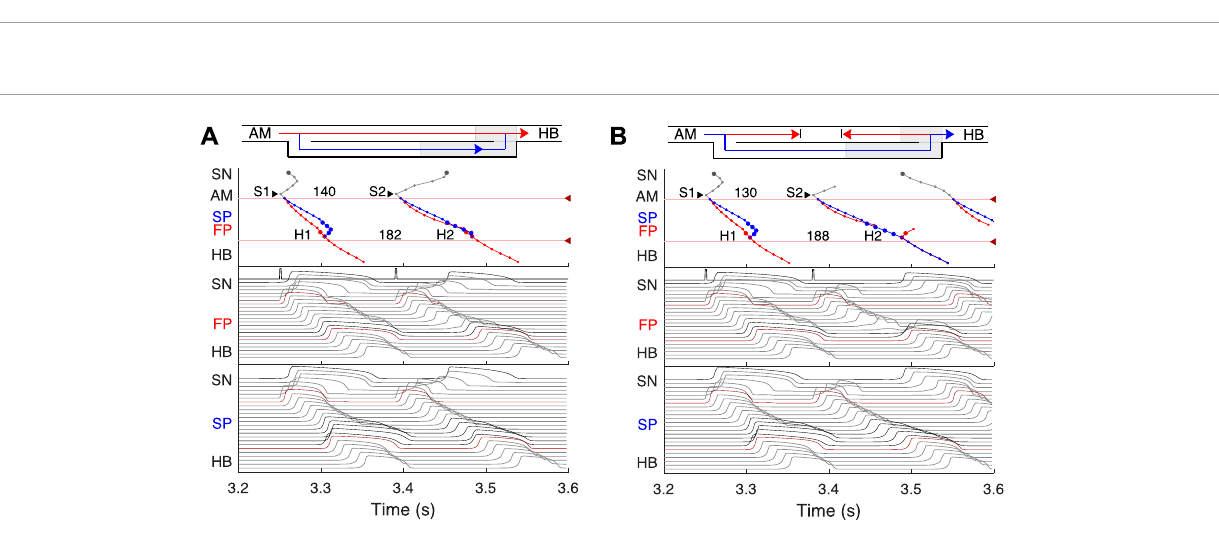
FIGURE 5 Atrial pacing in the control case with S1S2 interval of 140 ms and 130 ms. (A) At 140 ms interval, the excitation wave arrives via the FP and SP to the PB almost simultaneously with a slight advance of the FP. (B) The conduction in the FP is stopped due to a functional conduction block. In the top panel, arrowhead markers indicate points of stimulation. Upper (between the markers) and lower numbers correspond to the S1S2 and H1H2 intervals, respectively. Short stimulation impulses are shown at the top of the middle